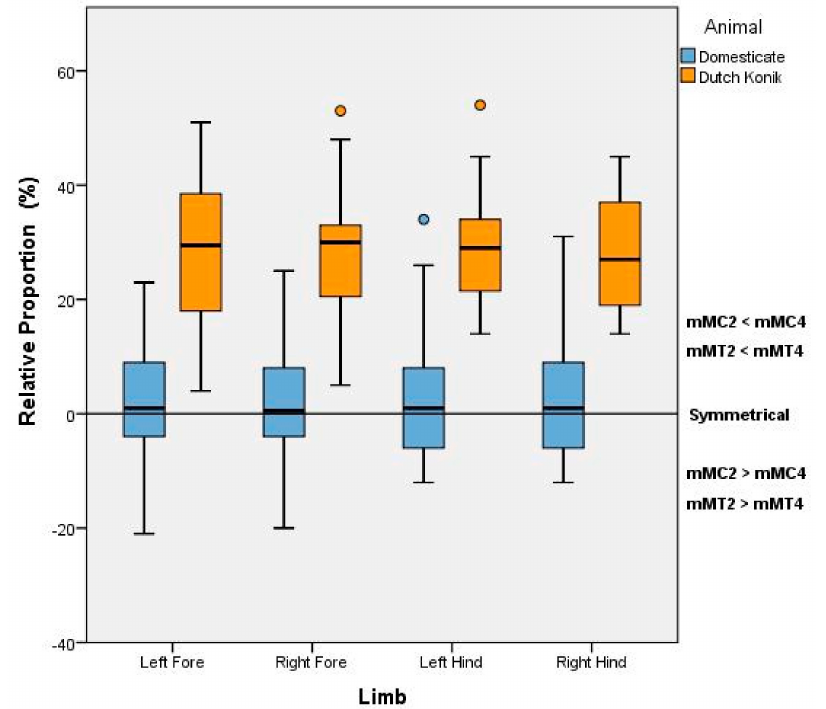
Figure 3. Variation in length and symmetry of the 2nd and 4th Metacarpals (MC) and Metatarsals (MT) between the Dutch Konik and Domesticate Horse, as indicated by their respective nodule to condyle measurements (mMC and